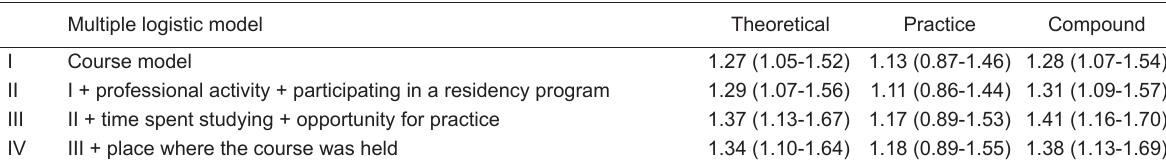
Table 4. Odds ratio (95% confidence interval) for theoretical, practice or compound outcome for incremental models of multiple logistic regression. Multiple logistic